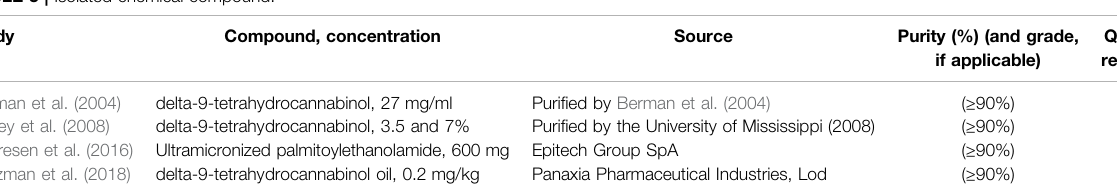
TABLE 3 | Isolated chemical compound.